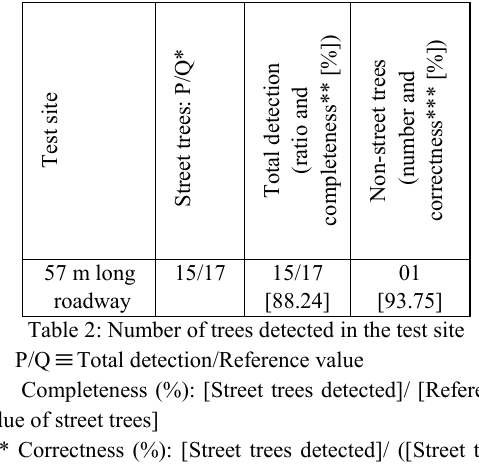
Table 2: Number of trees detected in the test site * P/Q (cid:123) Total detection/Reference value ** Completeness (%): [Street trees detected]/ [Reference value of street trees] *** Correctness (%): [Street trees detected]/ ([Street trees detected] + [Non-street trees